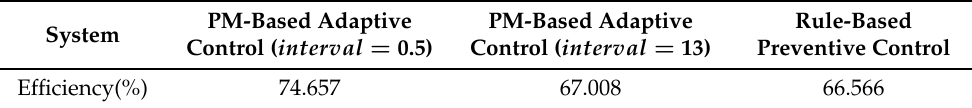
Table 4. The average efficiency values of our PM-based adaptive control with interval = 0.5 r/min, 13 r/min and the rule-based